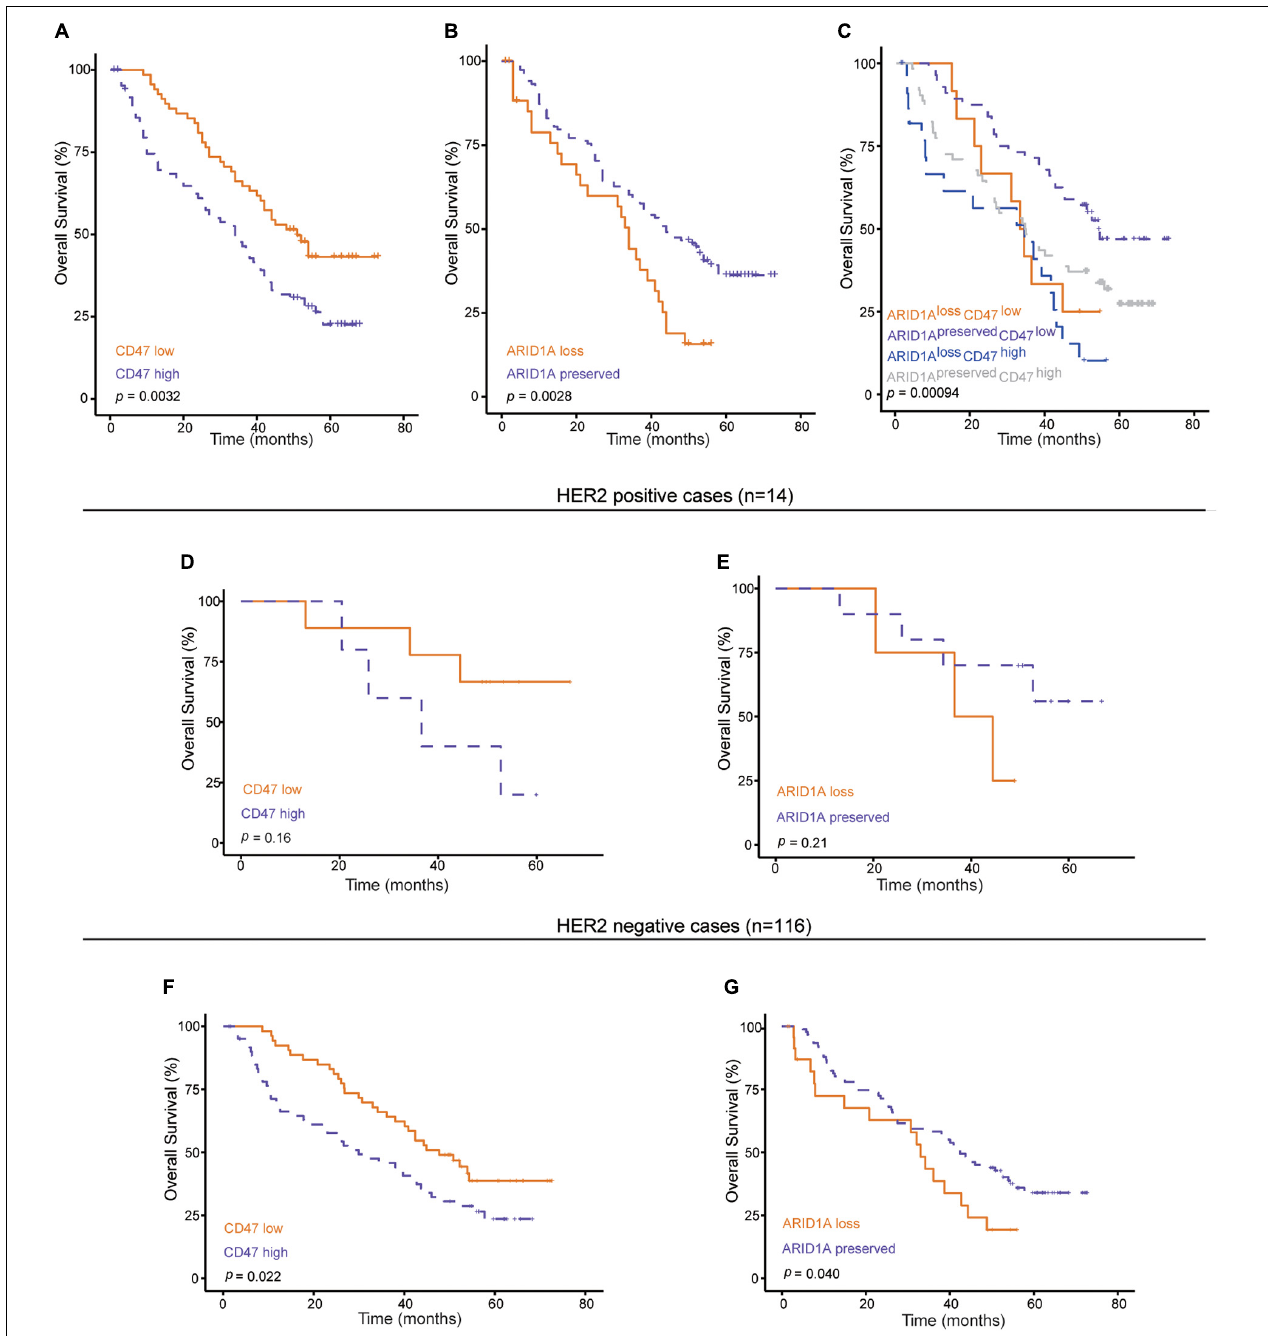
FIGURE 3 | Kaplan–Meier curves under various conditions. (A,B) Survival curves according to ARID1A status or CD47 expression ( n = 154). (C) Survival curves according to ARID1A status combined with CD47 expression level ( n = 154). (D–G) Survival curves according to ARID1A status or CD47 expression with HER2 positive or